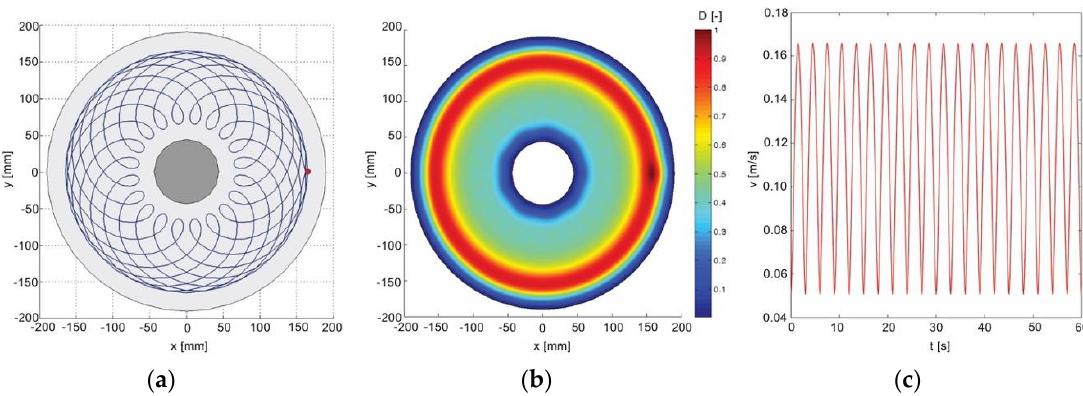
Figure 1. The influence of the parameter k 1 = − 20/9 on: ( a ) the shape of the abrasive grains trajectory; ( b ) the trajectories density on the lapping plate; and ( c ) the distribution of relative velocities v ( t ) .